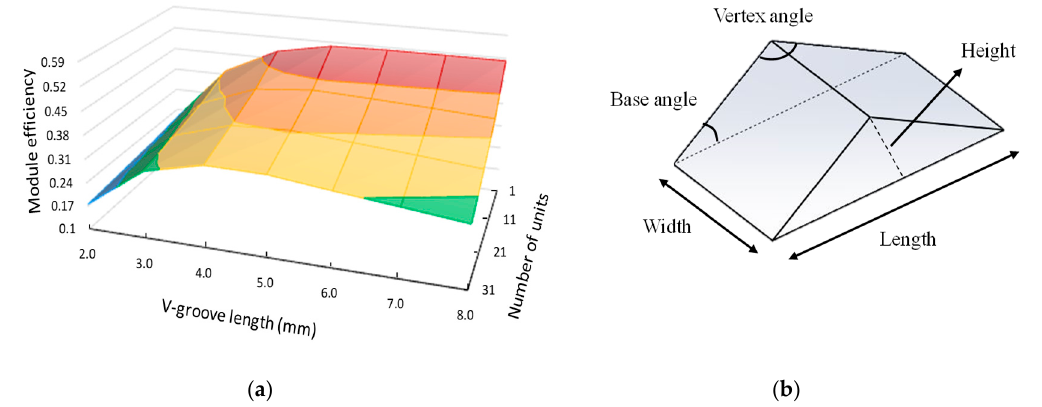
Figure 5. ( a ) Relation between the module efficiency for the whole solar spectrum, the length of the v-groove, and the number of units based on the simulation results and ( b ) structure of the v-groove.